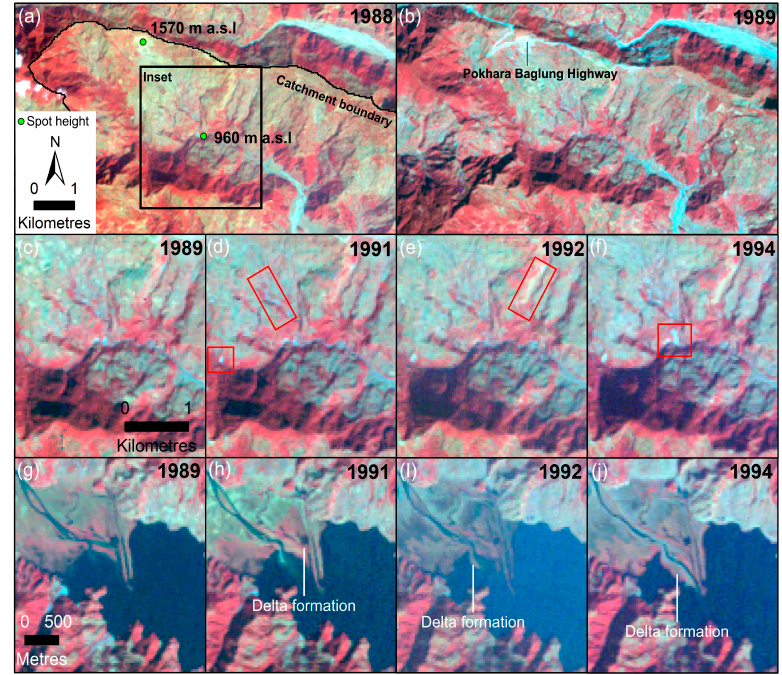
Figure 6. ( a–f ) Landscape changes in the upper part of the Phewa catchment from 1988–1994, and ( g–j ) lake shrinkage on the western shore. Images are Landsat 5 false colour composites (bands: near-infrared, red, and blue).